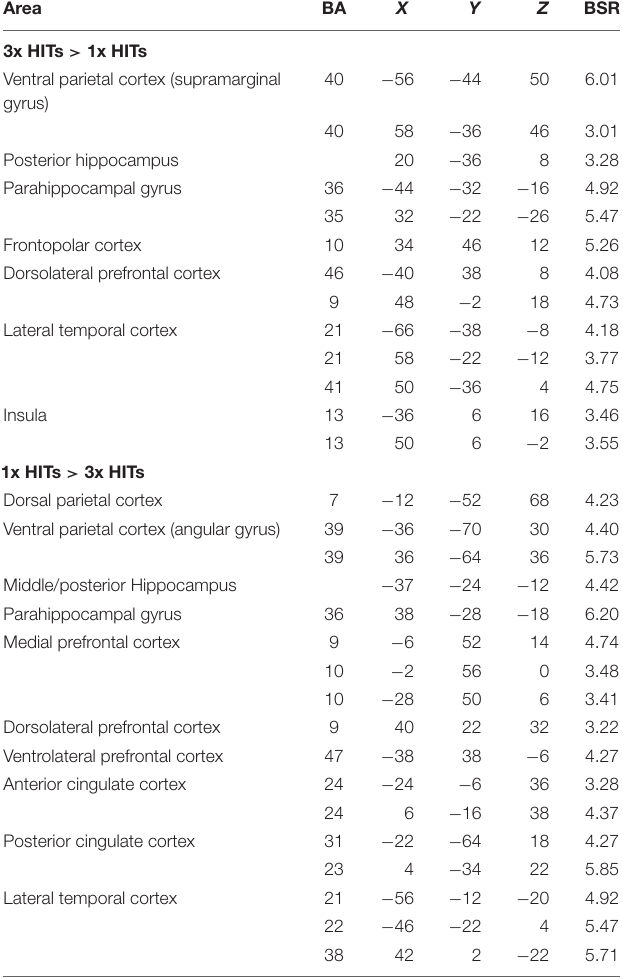
TABLE 2 | Networks related to study